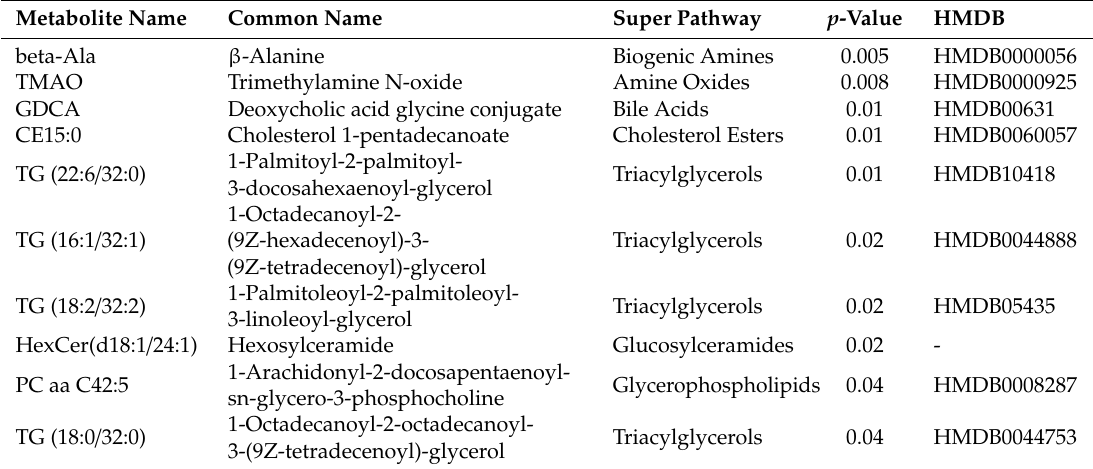
Table 6. List of the plasma metabolites showing significant changes in plasma levels in Rb group after 8 weeks of Rb